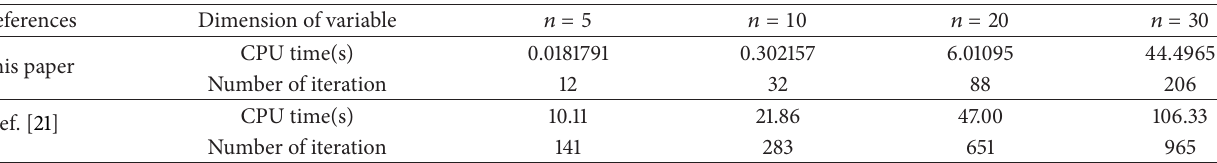
Table 3: Numerical results for Example